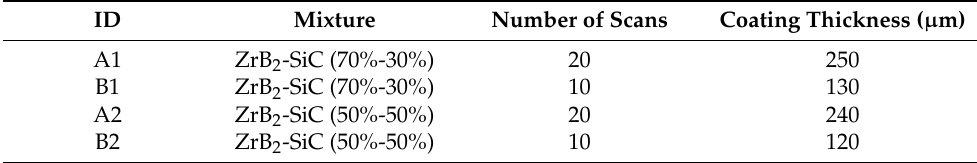
Table 1. List of high-pressure plasma spray (HPPS) deposition